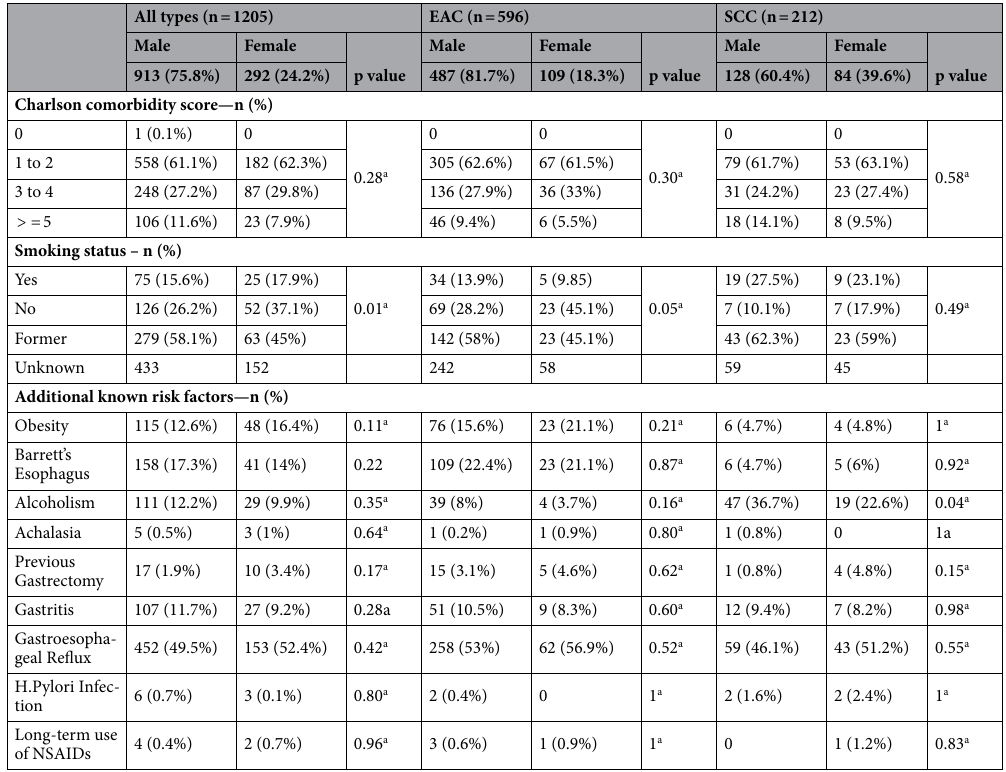
Table 3. Risk factors by sex for all types of esophageal cancer combined, esophageal adenocarcinoma (EAC) and squamous cell carcinoma (SCC), UH Seidman Cancer Center Database (2005–2020). a Chi-square